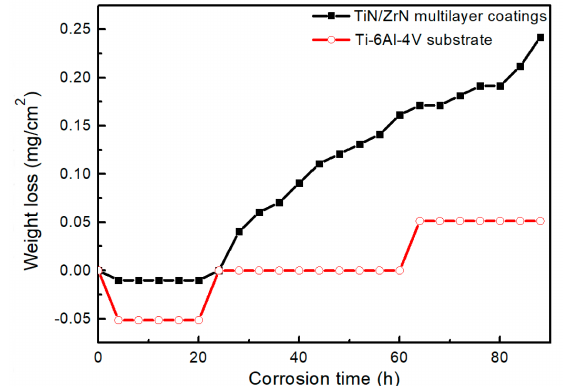
Figure 11. Comparison of the mass loss trend for Ti-6Al-4V substrate and TiN/ZrN coating.